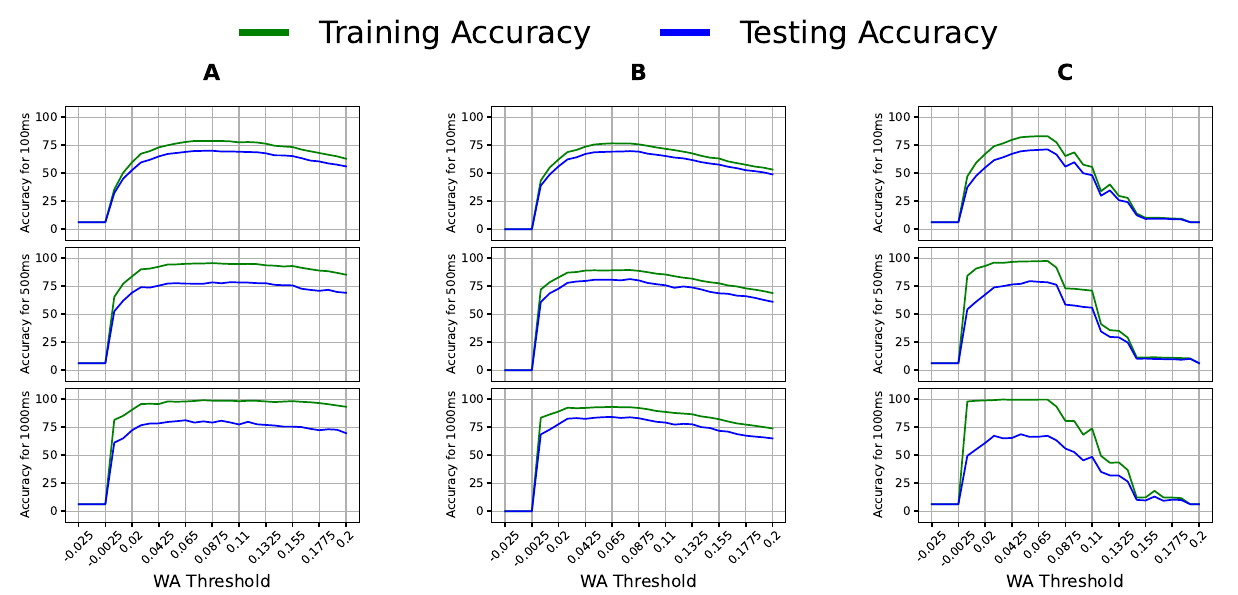
Figure 5. Classification accuracy of ( A ) logistic regression (LR), ( B ) linear discriminant analysis (LDA), and ( C ) quadratic discriminant analysis (QDA) with multiple WA threshold values on varying window sizes using the sEMG data of Participants 4, 5, and